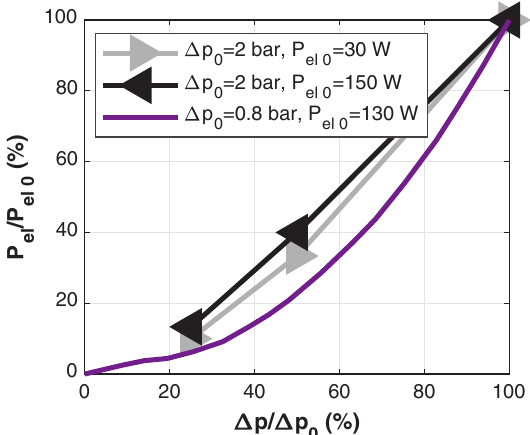
Figure 9. Off-design performance of MTs.